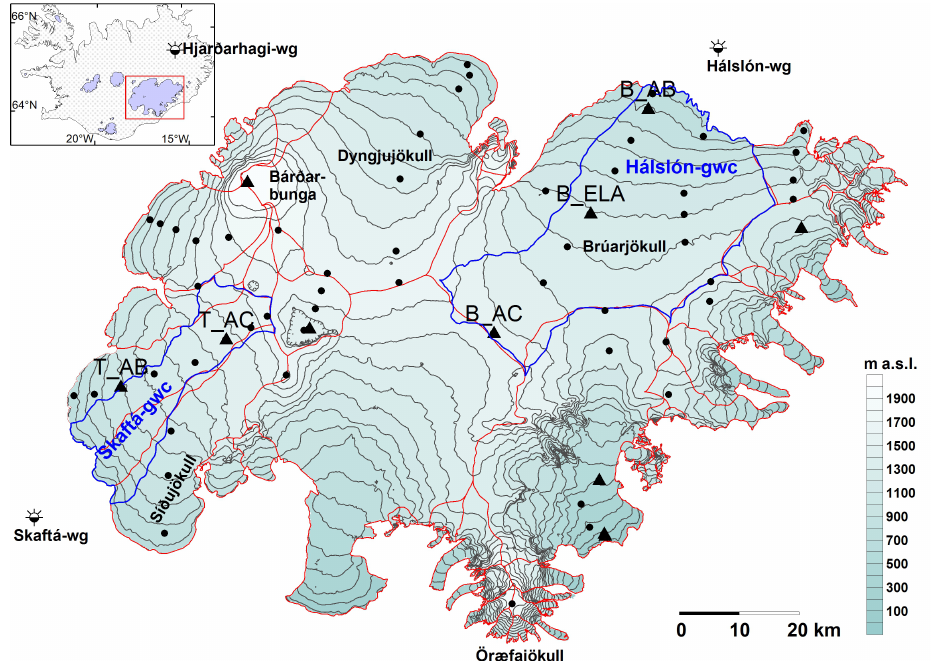
Figure 1. Location of AWS stations (black triangles) and surface mass balance sites (black dots) used in this study. The red lines show the outlines of the ice divides, while the bluelines show the outlines of the Skaftá (west) and Hálslón (east) glacial water catchments. The symbols outside the ice cap show the water gauges